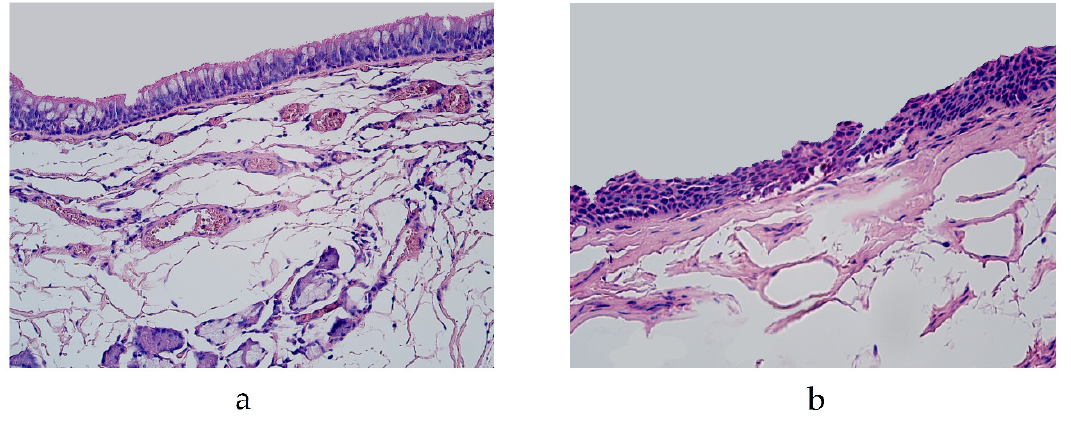
Figure 1. Micrograph of lungs routinely stained by hematoxylin and eosin. ( a ) Pseudostratified ciliated epithelium in the bronchi of 19-year-old male. X 200; ( b ) squamous stratified epithelium in the bronchi of 46-year-old male. X 250.